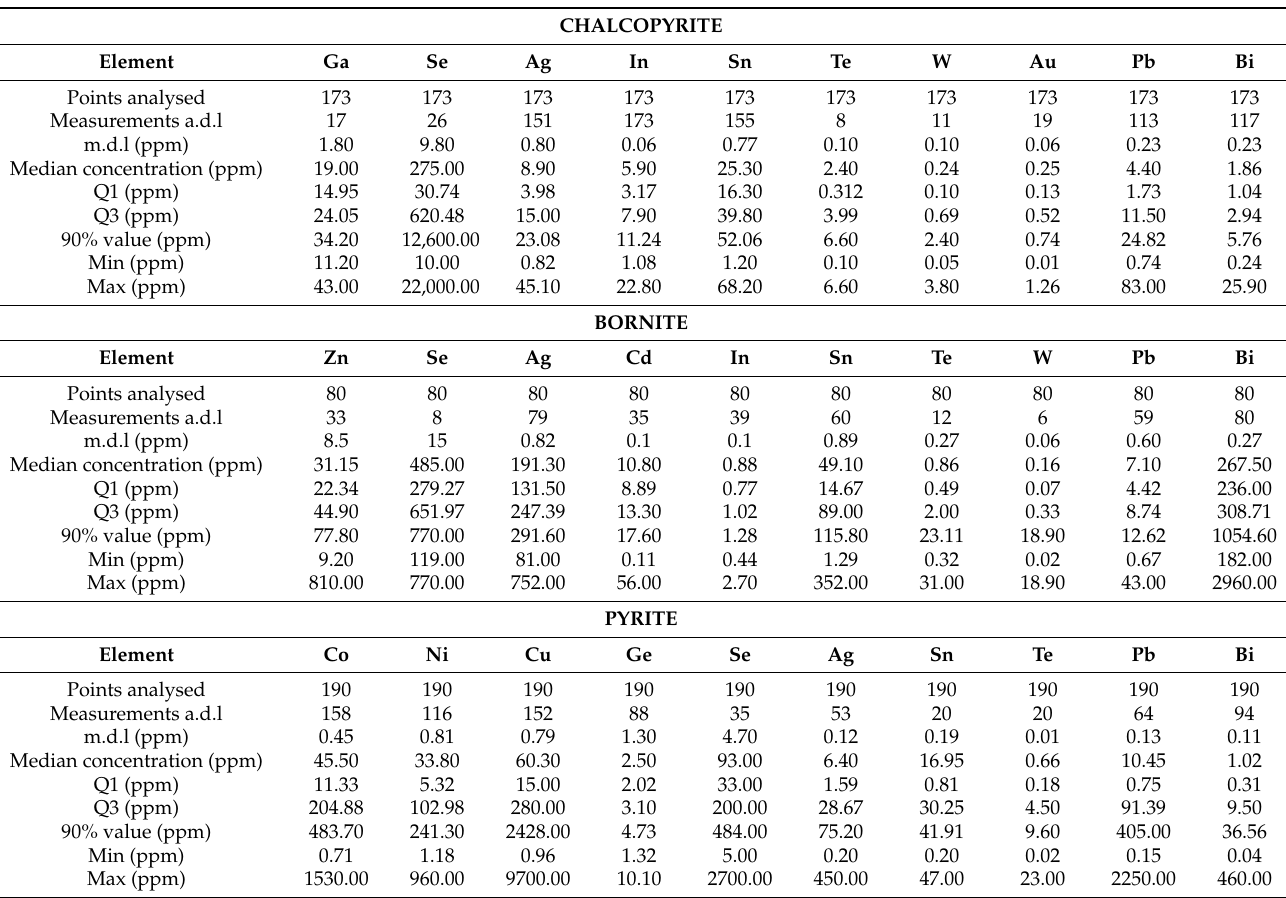
Table 1. Summary statistics of LA-ICP-MS analyses for selected trace elements in sulfides from the Chuquicamata Under- ground deposit. Q1: first quartile (25% of the data below this concentration), Q3: third quartile (75% of the data below this concentration). Data are displayed in parts per million by weight